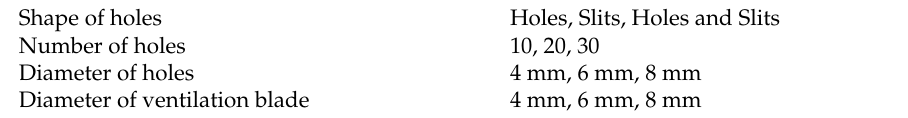
Table 5. Design variables and